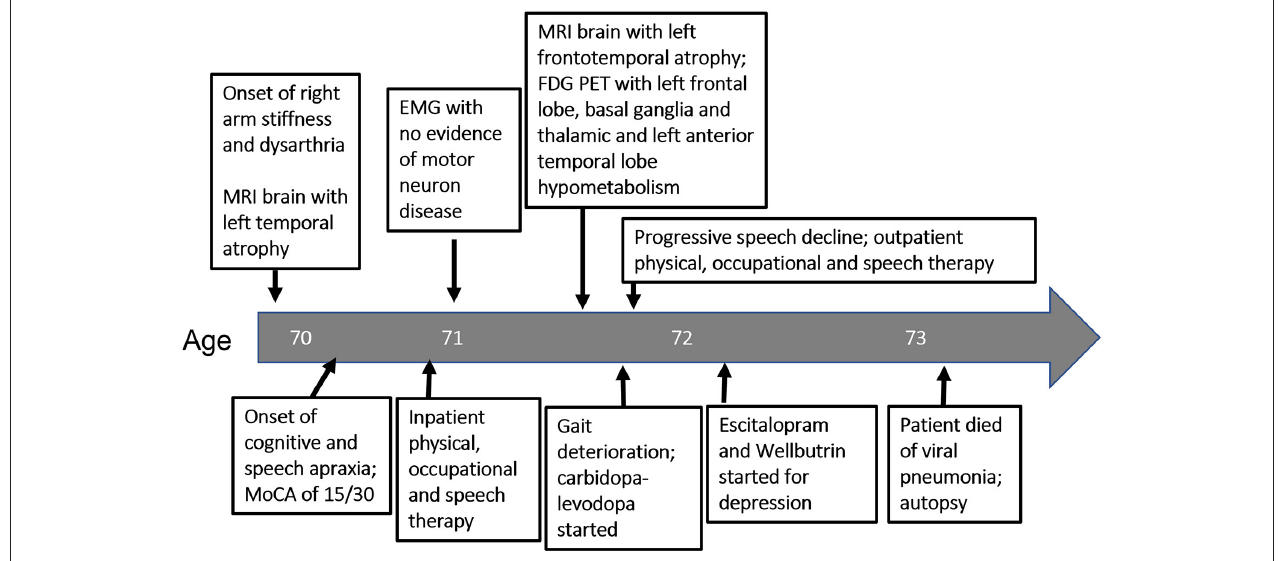
FIGURE 2 | Timeline of diagnostic testing and intervention from symptom onset (left) to patient death (right) as it relates to patient’s